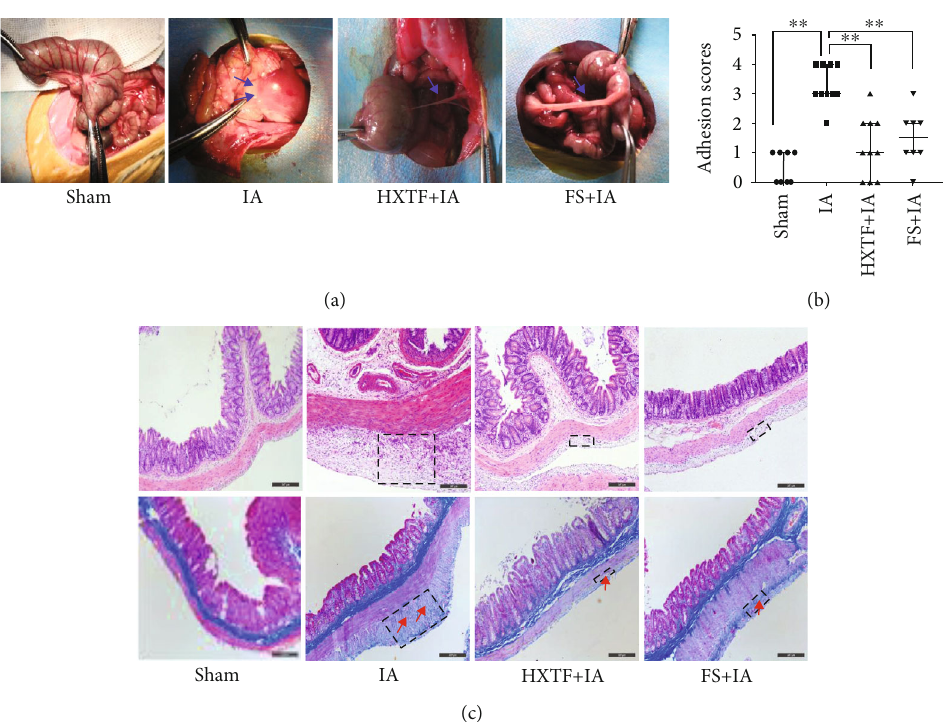
Figure 8: E ff ect of HuoXueTongFu Formula (HXTF) on reducing adhesion formation. Groups: the sham group, the intraperitoneal adhesion group (IA), the HXTF+IA group, and the fl uvastatin (FS)+IA group. (a) Gross observation of adhesion formation. (b) The adhesion score between groups. Data are expressed as the median ± IQR ( n = 10 ). ∗ p < 0 : 05 and ∗∗ p < 0 : 01 , respectively. (c) E ff ect of HXTF on histological changes of the cecum (HE staining and Masson staining, the black dotted box indicates the adhesion area and the red arrow indicates the collagen deposition. Original magni fi cation, × 100, bar = 200 μ m